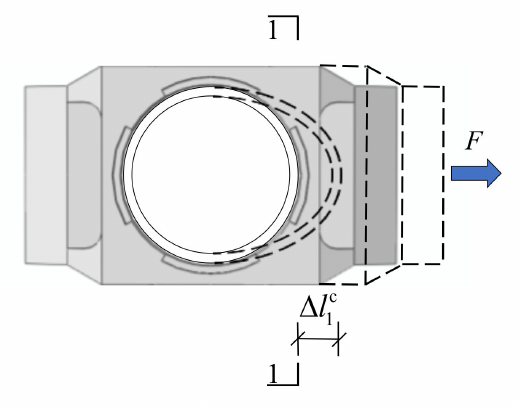
Figure 15. Schematic diagram of ∆ l c